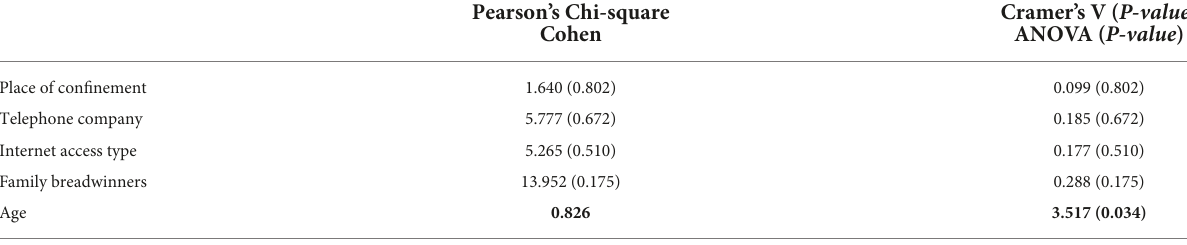
TABLE 3 Measures of association and difference between categories for the study variables and personal situation. Pearson’s Chi-square